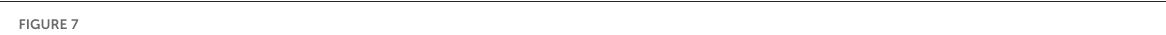
FIGURE7 enrichment of biological functions. (B) STRING was used to analyze the interaction network among the selected differentially expressed genes. (C) The heatmap of the expression patterns of interacted genes in sciatic nerve stumps after nerve injury. Red color indicates up-regulation and blue color indicates down-regulation. (D) The interaction network of SS18L1 and associated proteins DF2, SMARCD1, SMARCA4,